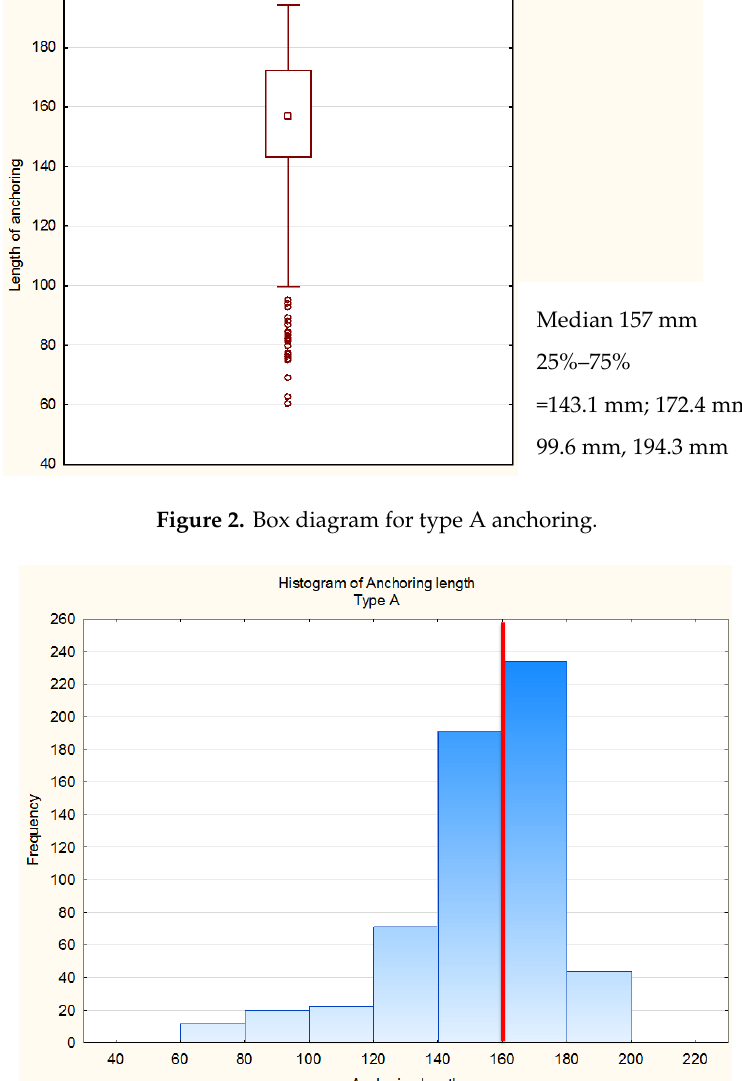
Figure 3. Histogram of anchoring length—type A.